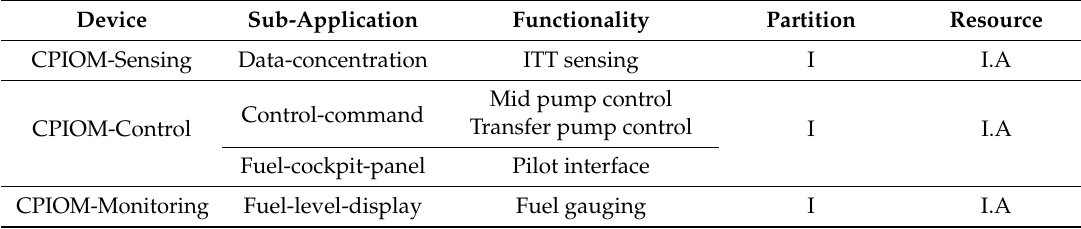
Table 2. Allocation of deployed sub-applications (scenario 2).